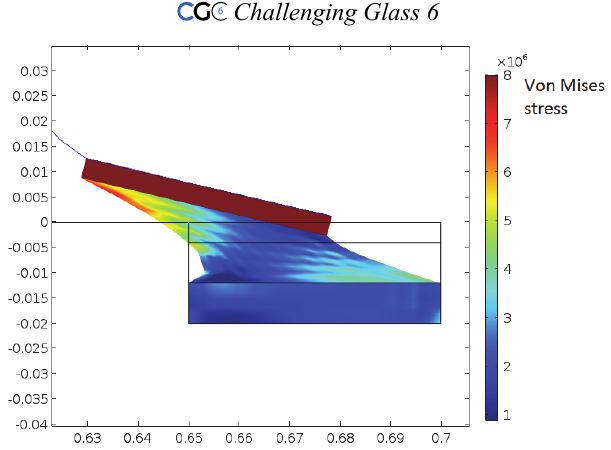
Fig. 16: Joint geometry corresponding to Fig. 12b but with sealant Young’s modulus divided by a factor 2. The maximum Von Mises stress value in a joint of lower Young’s modulus is equal to 6.7Mpa (orange color) compared to 10MPa, representing a VM stress reduction of more than 30%. We insist at this point that using a material of lower Young’s modulus is only beneficial if Young’s modulus decrease is not detrimental to the tensile